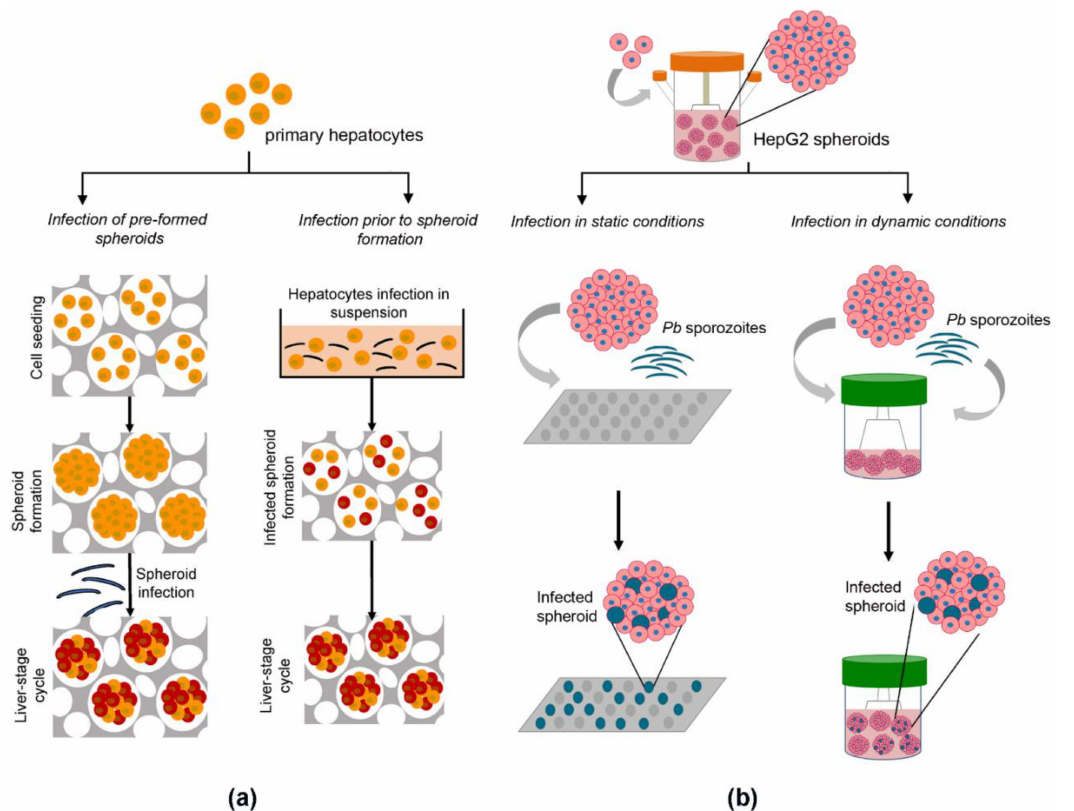
Figure 2. Engineered 3D models for addressing Plasmodium infection. ( a ) Spheroid infection with P. cynomolgi ( Pc ) in cellulosic sponge scaffolds. Spheroids of primary simian hepatocytes generated in cellulosic sponges and infected with Pc sustained Pc invasion and development (left panel); single cells were infected with Pc sporozoites before spheroid formation and infected cultures were seeded in the cellulosic sponges for the generation of Pc -infected spheroids (right panel). Image adapted with permission of [111]. ( b ) Scaffold-free spheroid infection with P. berghei ( Pb ). Spheroids generated in stirred-tank culture systems were transferred into 96-well plates (static, left panel) or into smaller scale stirred-tank culture systems (dynamic, right panel) and infected with Pb sporozoites, sustaining Pb invasion and development